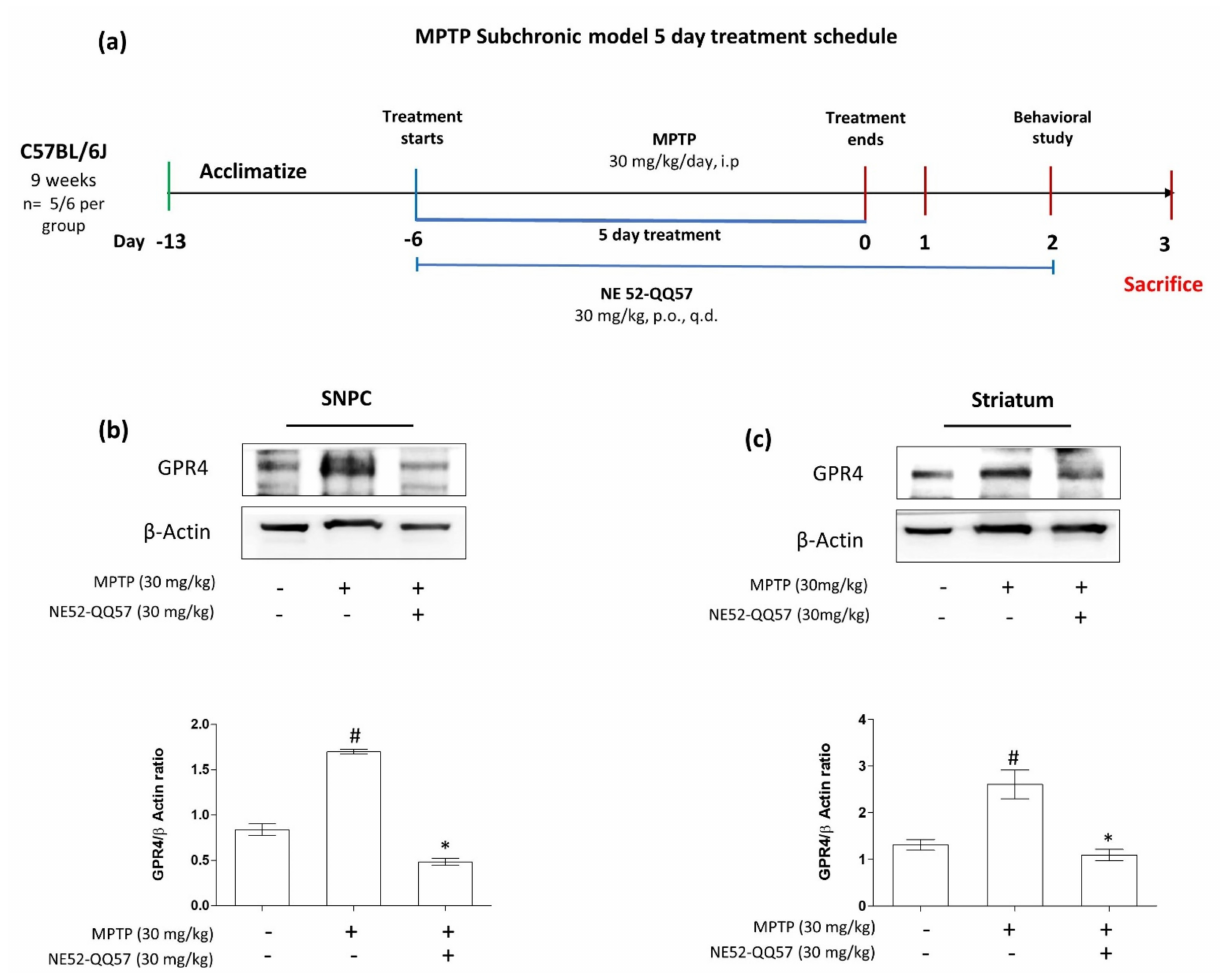
Figure 1. The effects of subchronic MPTP administration on the GPR4 protein expression levels in the substantia nigra and striatum of the mouse brain. ( a ) Schematic representation of the treatment and behavioral study schedule for animal experiments. GPR4 protein expression and its densitometric analysis in ( b ) the substantia nigra pars compacta (SNpc) and ( c ) the striatum measured in tissue samples collected 3 days after the final MPTP administration. β -Actin expression levels used as an internal control. Data are presented as the mean ± SEM. One-way ANOVA, followed by Tukey’s multiple comparison test, was used to compare differences between groups. # p < 0.05 when the MPTP-treated group was compared with the vehicle-only group; * p < 0.05 when other treated groups were compared with the MPTP-treated group. p.o.: